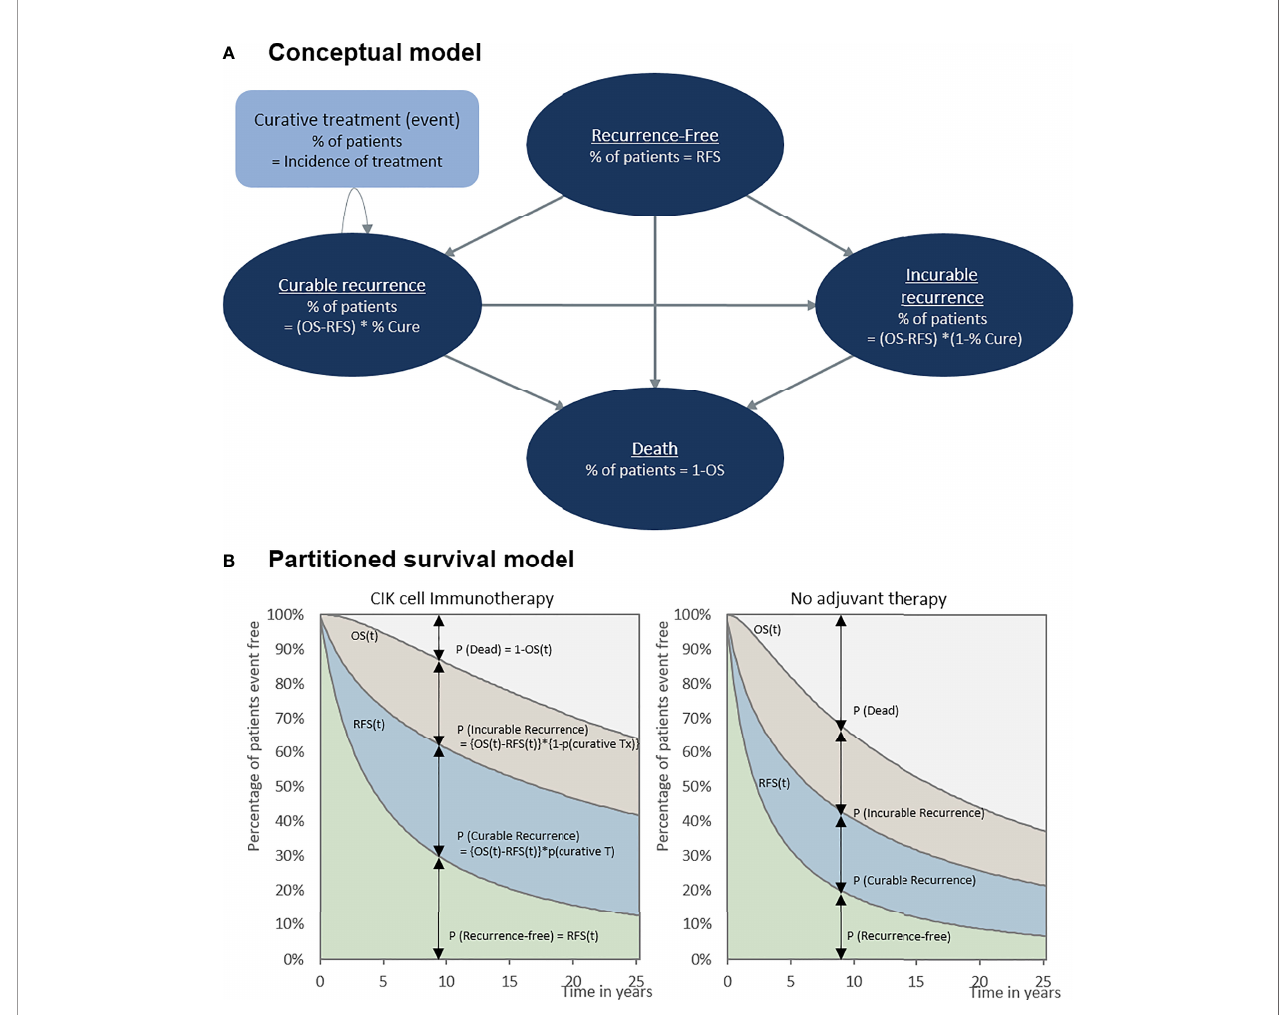
FIGURE 1 | Cost-effectiveness model. (A) Conceptual model and (B) partitioned survival model. OS, overall survival; RFS, recurrence-free